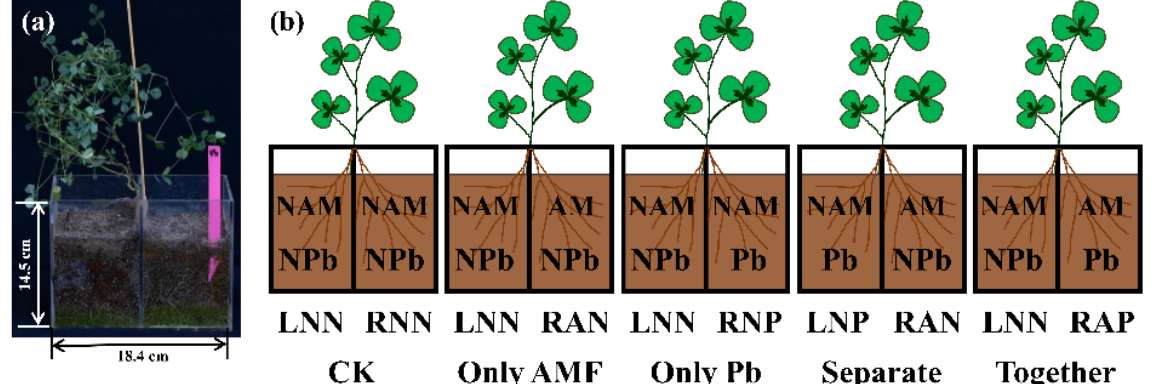
Figure 1. ( a ) Split root system used for the study of the influence of R. irregularis on Pb uptake by M. truncatula . ( b ) The 2 compartments of the root systems inoculated with/without R. irregularis , and 2 compartments with/without Pb applied after 4 weeks of mycorrhizal colonization. NAM = non-mycorrhizal treatment; AM = arbuscular mycorrhizal fungi inoculation; Pb = Pb treatment; NPb = non-Pb treatment. CK = control treatment. Only Pb = Pb was added to only 1 compartment; Only AMF = AM fungi was added to only 1 compartment; Separate = Pb and AM fungi were added into the split-root system in the 2 compartments separately; Together = Pb and AM fungi were added into the split-root system in the same compartment together. LNN = no AM fungi or Pb was added to the left compartment; RNN = no AM fungi or Pb was added to the right compartment; RAN = AM fungi was added to the right compartment without Pb; RNP = Pb was added to the right compartment without AM fungi; LNP = Pb was added to the left compartment without AM fungi; RAP = AM fungi and Pb were added to the right compartment.